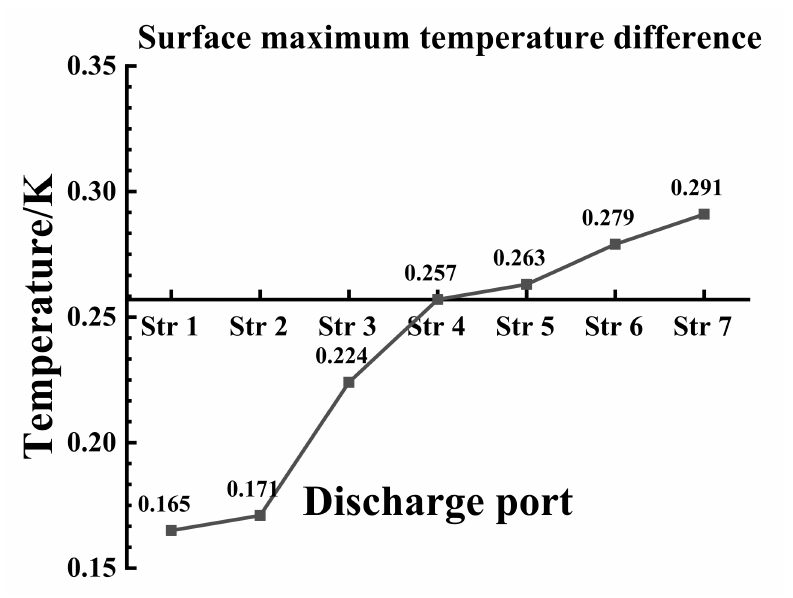
Figure 17. Maximum surface temperature difference of the thermal jet for different radius ratios of oval discharge